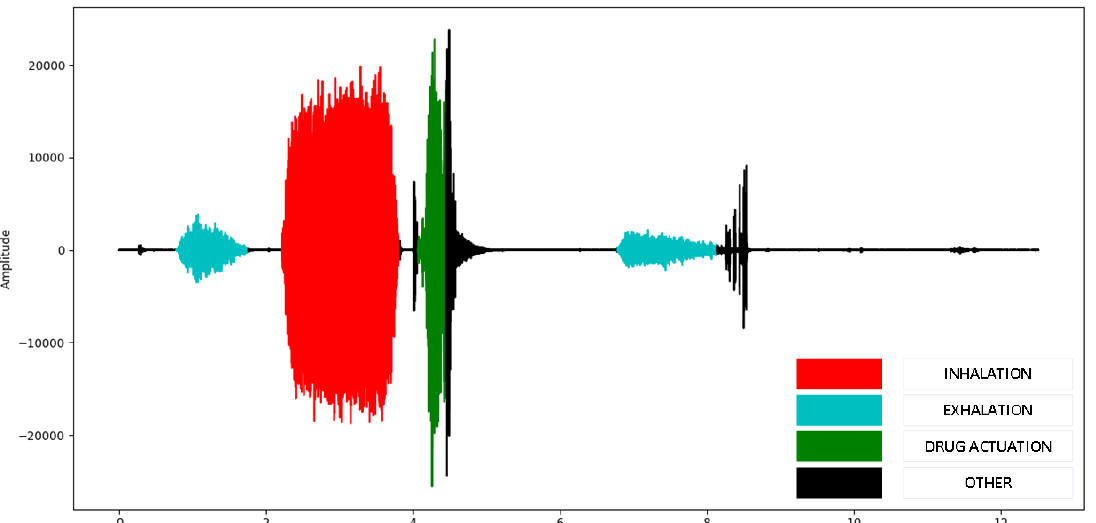
Figure 3. Annotated audio file of 12 s. Red color corresponds to inhalation, cyan to exhalation, green to drug activation and black to other